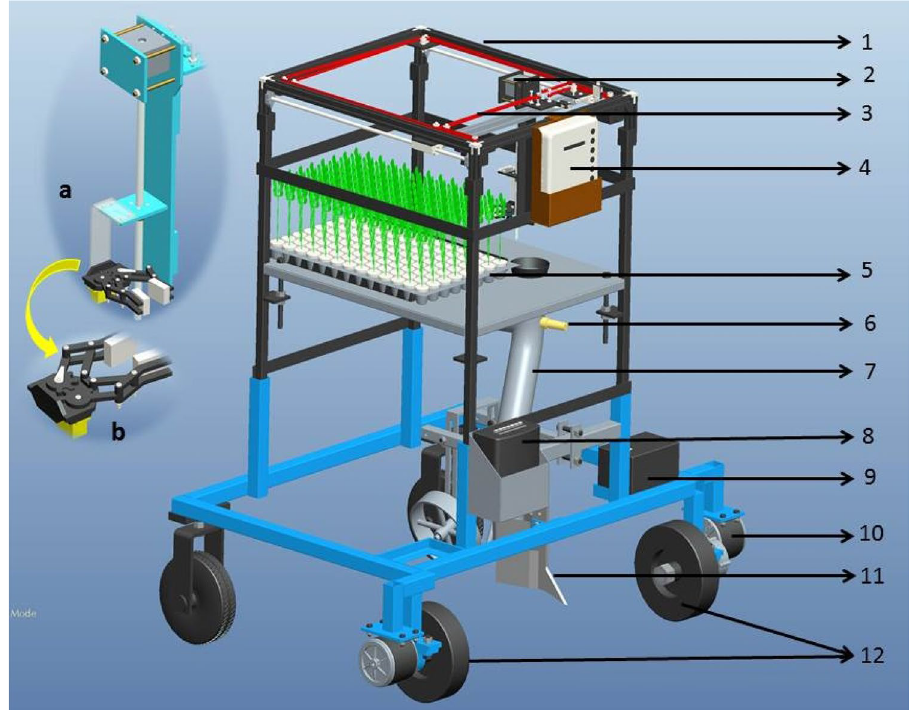
Figure 1. Robot transplanter. ( a ) Manipulator, ( b ) end-effector. (1-Main frame; 2-manipulator; 3-belt; 4-control unit for seedling pick-up; 5-seedling tray; 6-photoelectric sensor; 7-delivery tube; 8-control unit for robot; 9-battery; 10-dc motor; 11-furrow opener; 12-wheels).